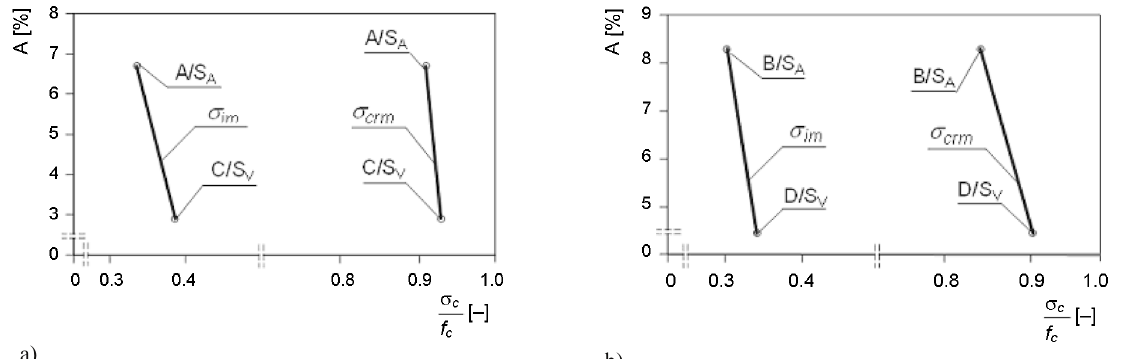
Fig. 12. Dependence of average relative levels of stress σ im and σ crm on total air content A in hardened self-compacting concrete (pore diameter range 10–4000 μ m): a) A/S A and C/S V ; b) B/S A and D/S V